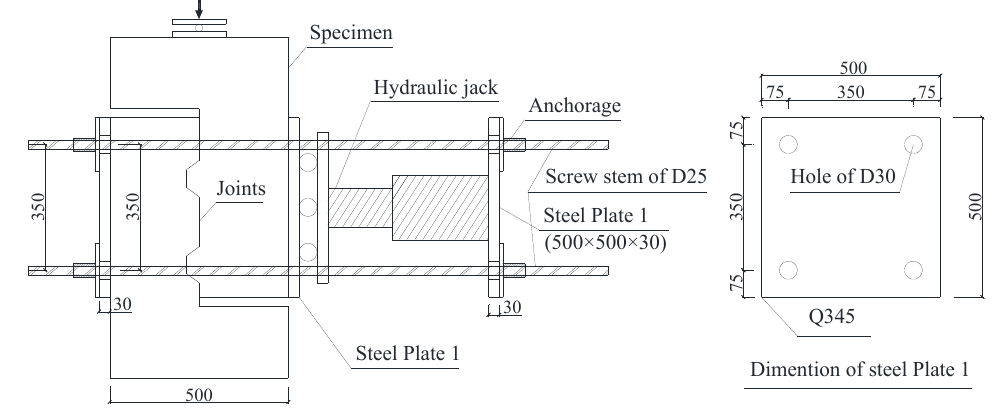
Figure 6. Typical setup for the push-off test.